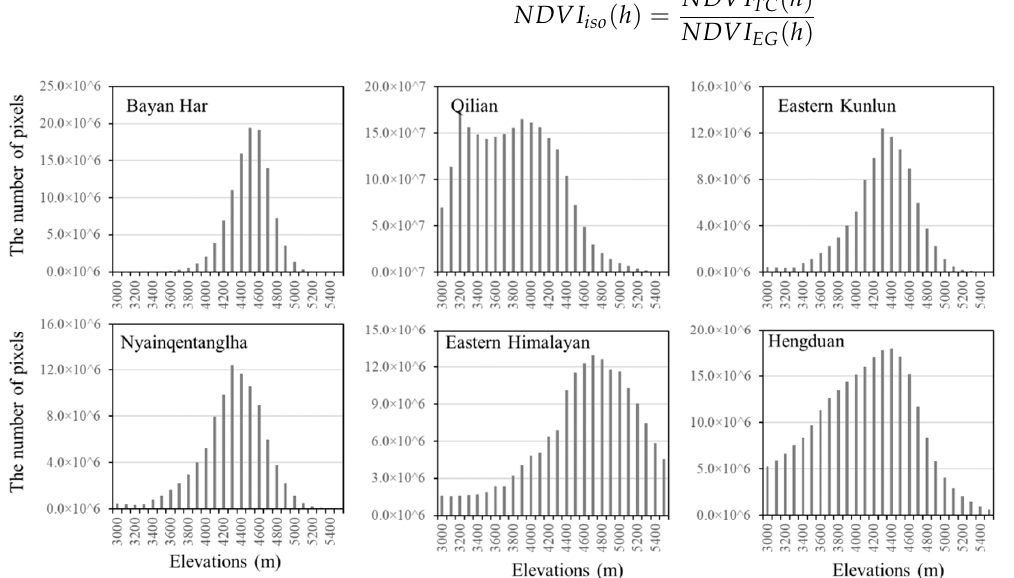
Figure 2. The number of vegetated pixels in each elevation bin for the six mountainous regions. According to the elevation distribution of vegetated pixels, we divided the elevations into each 100 m bin between 3000 to 5500 m. For example, all vegetated pixels ranging from 2950 to 3050 m were used for the 3000 m bin. To reduce the uncertainty, we excluded the bin with the number of vegetated pixels smaller than 10,000 pixels from further analyses. Therefore, the elevational gradient of NDVI ( 𝑁𝐷𝑉𝐼 (cid:3006)(cid:3008) ) at the elevation bin h was